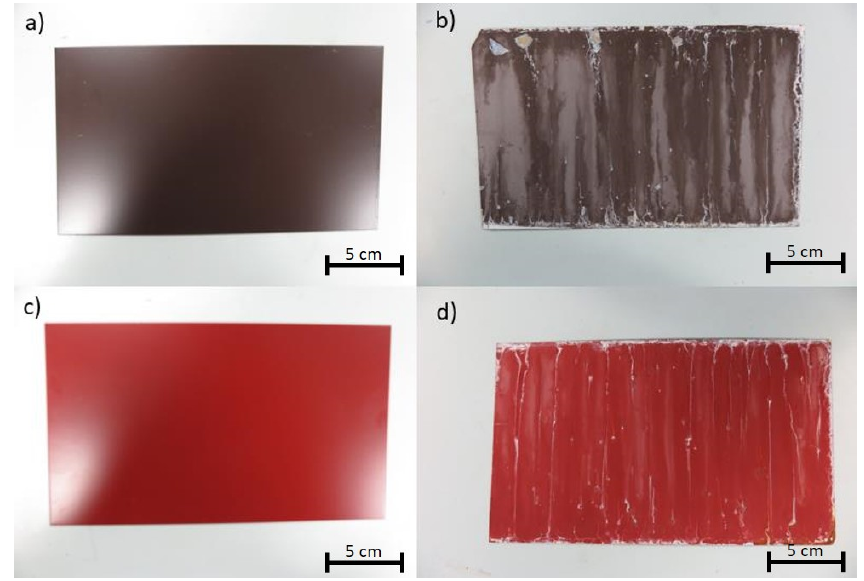
Figure 8. Red-N and Brown-N surfaces at the initial stage ( a , c ) and after the fourth degradation cycle ( b , d ).